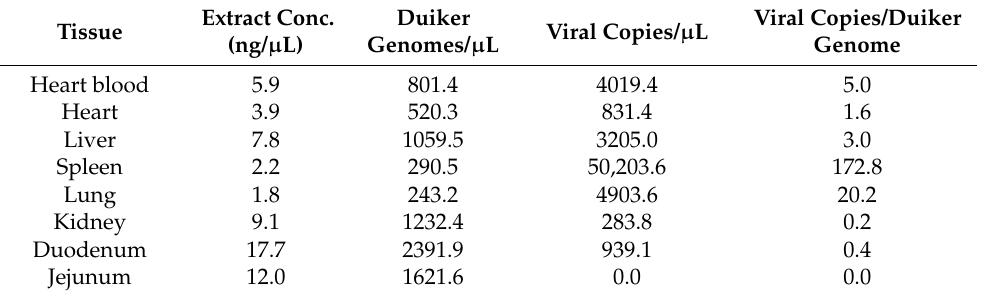
Table 3. Estimated viral copies per duiker genome. To estimate the size of the Maxwell’s duiker genome we calculated the average genome size for bovids in the Animal Genome Size Database, Release 2.0 (www.genomesize.com), using the average species genome size for sheep ( Ovis aries ) and domestic cattle ( Bos taurus ), for which there were multiple entries. A haploid bovid genome was estimated to roughly equal 3.7 pg, so that one Maxwell’s duiker cell would contain approximately 7.4 pg of